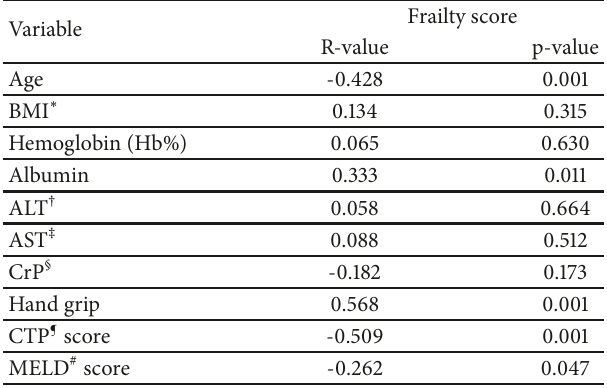
Table 2: Correlation between Frailty score and other